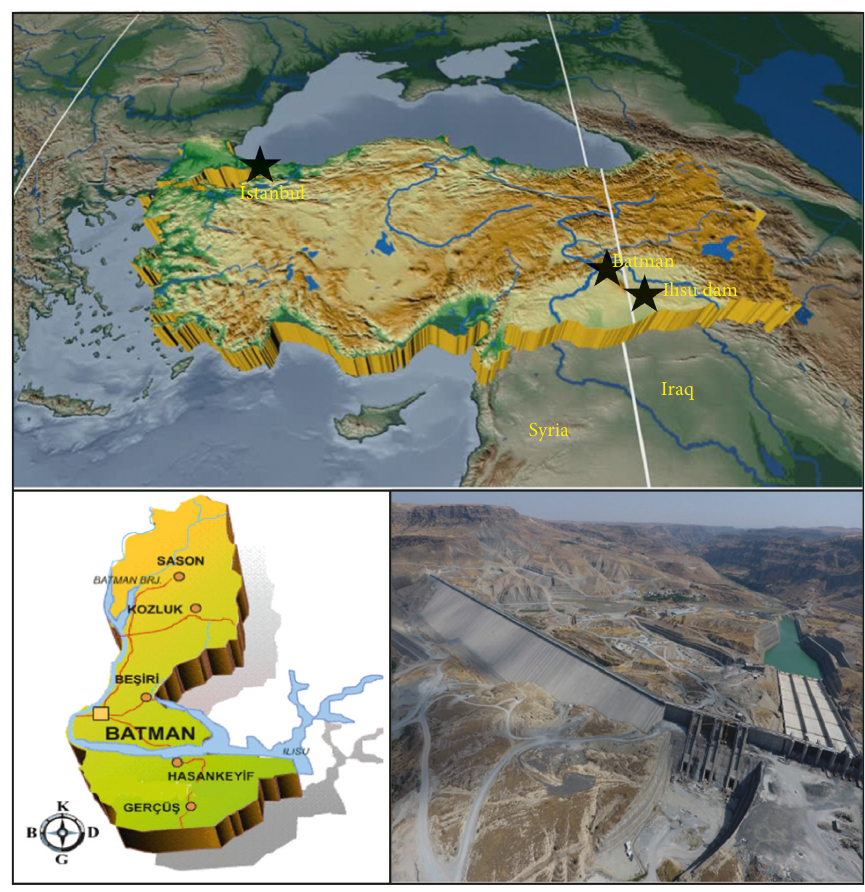
Figure 1: General view of the Ilısu dam